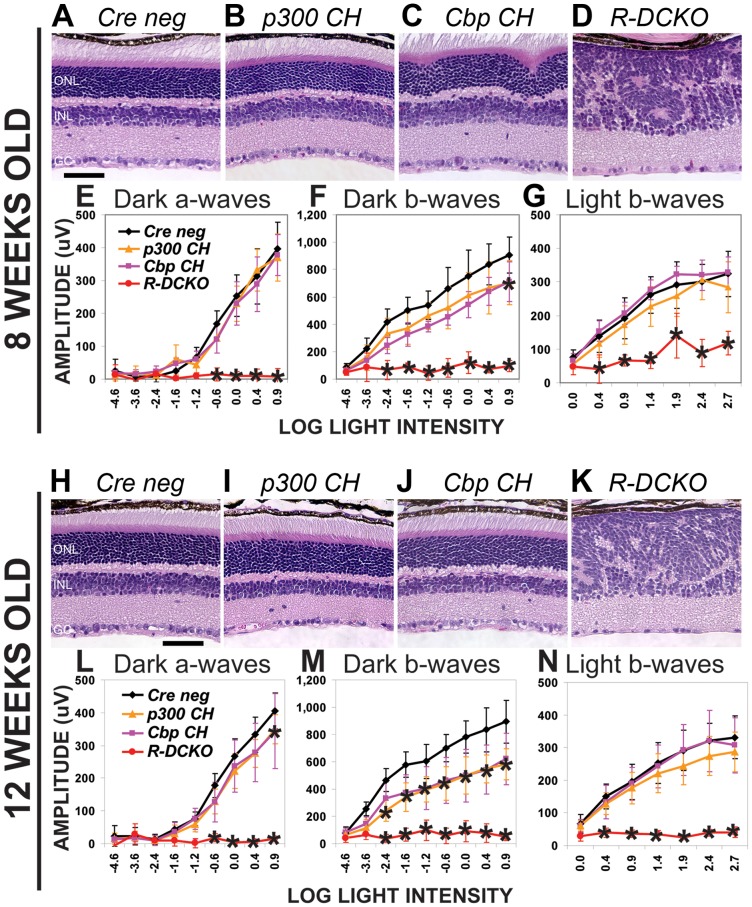
Compound heterozygotes show age-dependent phenotypes.
A–D. Cross-sections of 8-week-old retinas stained with H&E show disrupted morphology similar to that seen at 4 weeks in Cbp CH and R-DCKO mice. Scale bar  = 50 μm. E–G. ERG testing shows persistence of the functional impairment in R-DCKO retinas (panels F and G). Dark-adapted b-wave deficits in some p300 CH mice tested at this time are reflected in the slightly decreased average and broad error bars for this genotype (Panel F orange line). Two-way repeated measures ANOVA indicated significance at p<0.0001 for dark-adapted a-waves (Panel E), b-waves (Panel F), and light-adapted b-waves (Panel G). H–K. Cross-sections of 12-week-old retinas stained with H&E. Morphologic abnormalities in Cbp CH retinas (panel J) have resolved, although whorls and rosettes are still seen in R-DCKO retinas (panel K). Scale bar  = 50 μm. L–N. ERG testing at 12 weeks revealed decreases in function in both Cbp CH and P300 CH, and R-DCKO retinas have lost cone responses in addition to rod function. Two-way repeated measures ANOVA indicated significance at p<0.0001 for dark-adapted a-waves (Panel L), b-waves (Panel M), and light-adapted b-waves (Panel N). Asterisks (*) indicate p<0.001 vs. Cre negative controls in post-hoc tests.